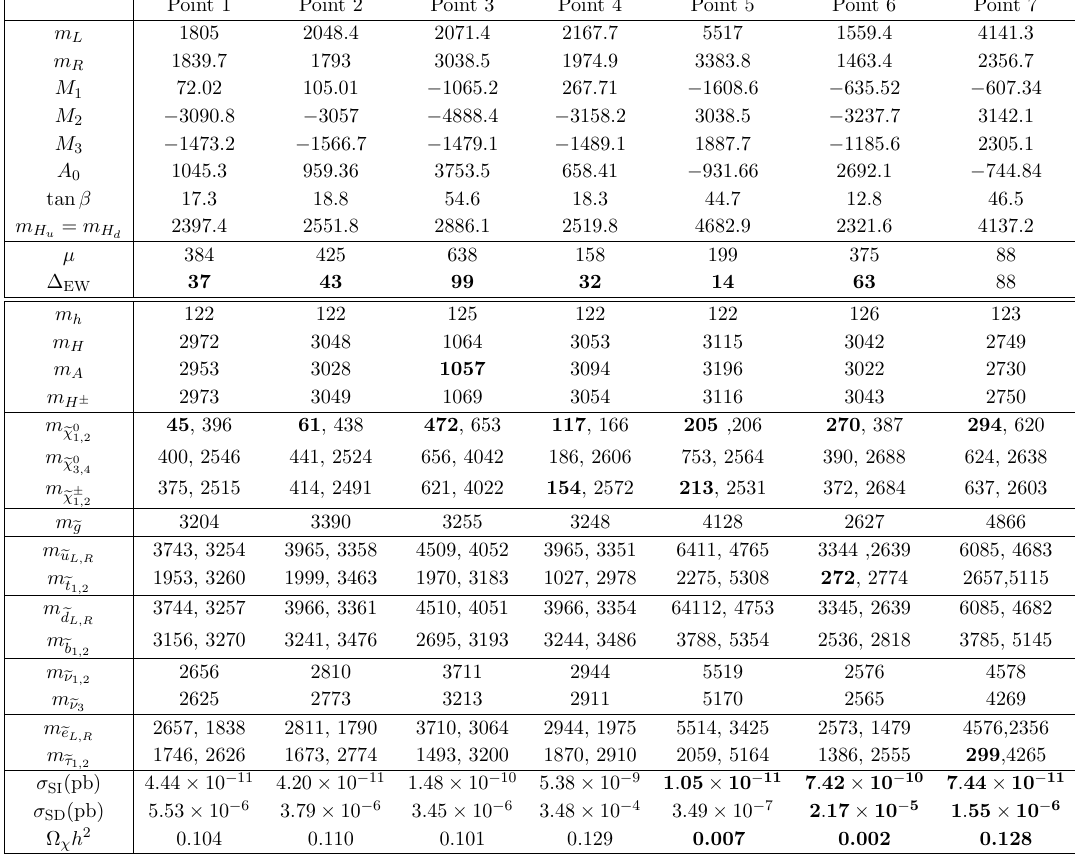
Table 1 . The particle spectra and properties of neutralino DM for a set of representative points for di(cid:11)erent regions of the viable parameter space. See the text in section 5 for details. The (cid:12)rst block shows high-energy parameters de(cid:12)ned at the GUT scale, while the others contain low-energy quantities. All quantities with mass dimension [ M ] are in the unit of